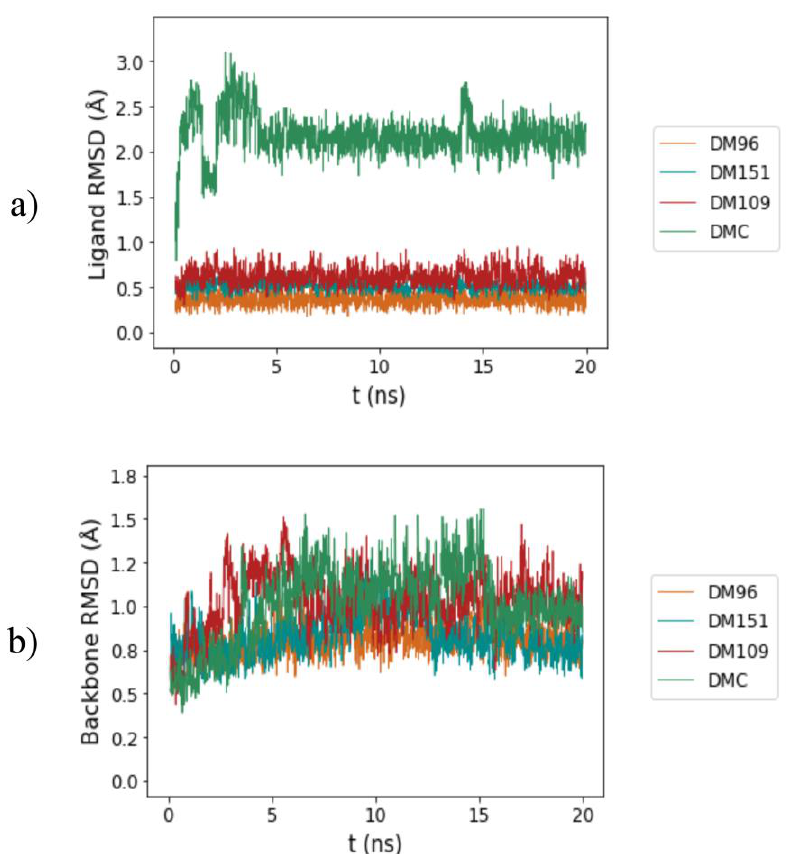
Figure 6. RMSD curves of: ( a ) curcumin derivative atomic positions, and ( b ) backbone atomic positions throughout 20 ns molecular dynamics simulations of hGSTP1-1/DM96 (red), hGSTP1-1/DM151 (orange), hGSTP1-1/DM109 (green), and hGSTP1-1/DMC (blue) complexes.